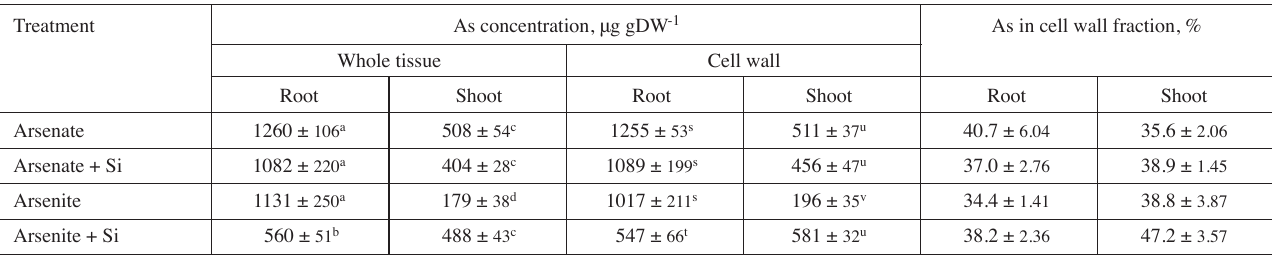
Tab. 3: Arsenic concentration in whole tissue and cell walls of roots and shoots of lettuce after treatment with 10 μM arsenite or arsenate with or without 1 mM potassium silicate for four days; n = 4, ±SE.